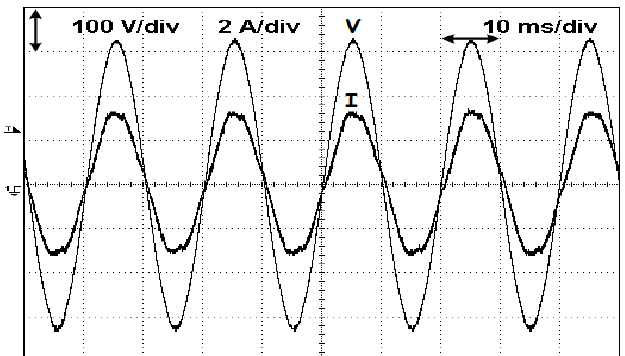
Figure 8. Voltage applied by the testing system and current injected by the solar inverter into the testing system when the injected power is 508 VA.